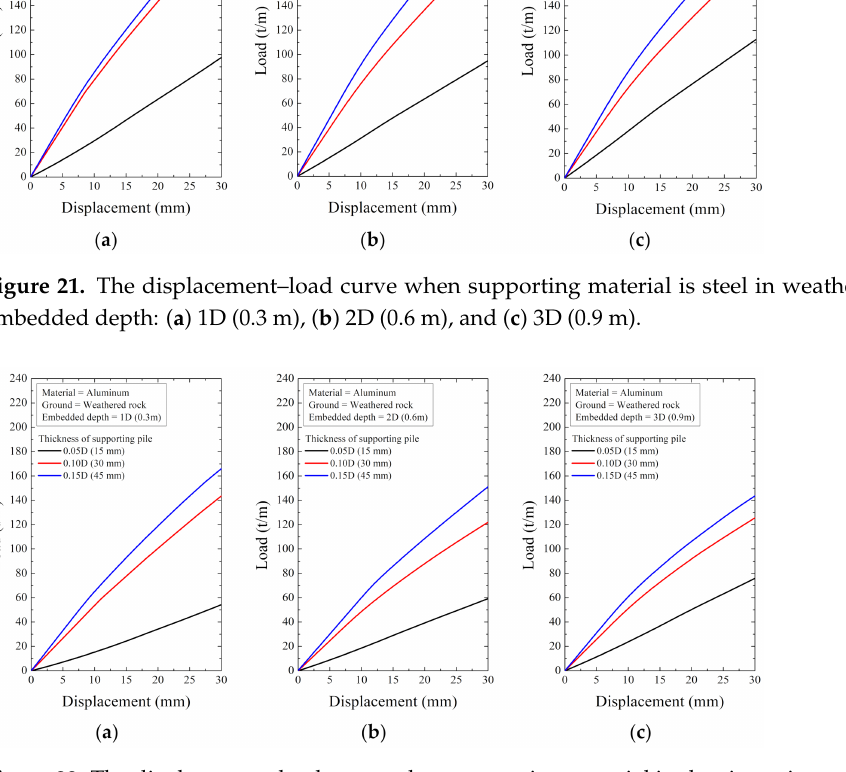
Figure 22. The displacement–load curve when supporting material is aluminum in weathered rock at embedded depth: ( a ) 1D (0.3 m), ( b ) 2D (0.6 m), and ( c ) 3D (0.9 m).